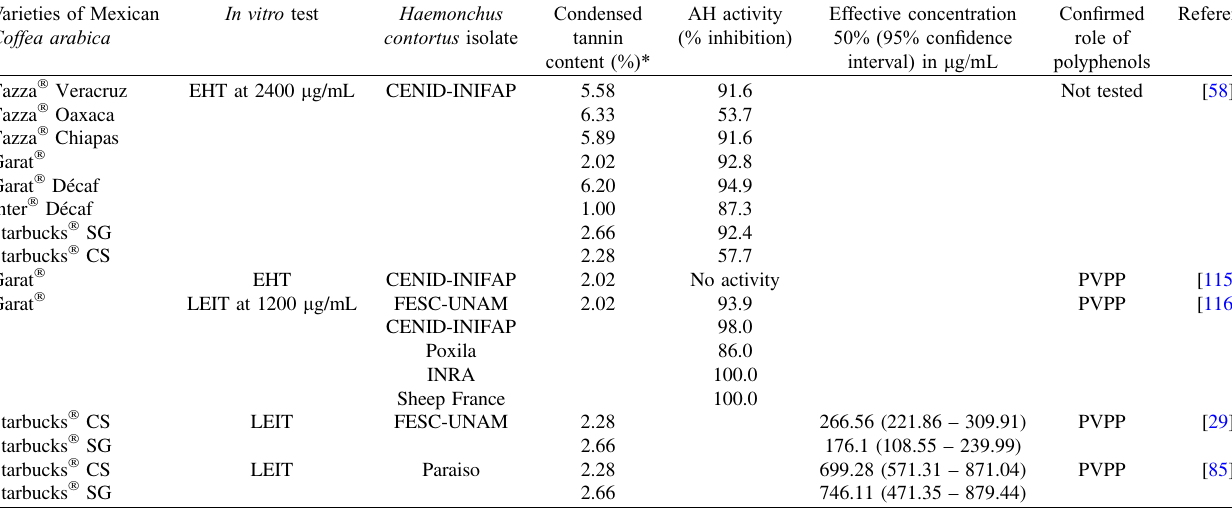
Table 1. In vitro anthelmintic activity of different varieties of spent coffee ground (SCG) acetone: water extracts against H. contortus eggs and L3 of different origins. The condensed tannin content of each extract (catechin equivalent) is also included, as well as the con fi rmation of the role of polyphenols in the in vitro activity by using the tannin inhibitor polyvinylpolypyrrolidone.